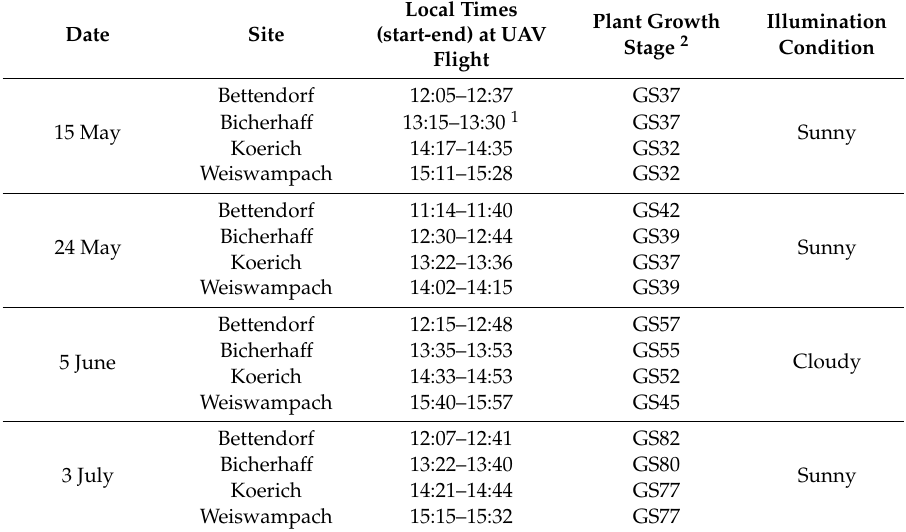
Table 2. A comprehensive overview of the data acquisition at the di ff erent sites in